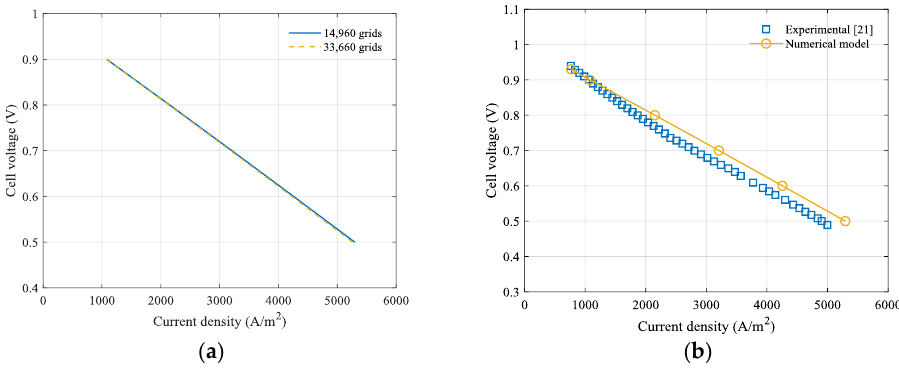
Figure 2. ( a ) Grid sensitivity test and ( b ) results comparison for validation with the results from the literature. The red circle and the blue square represent the numerical results of the present study and the experimental results of reference [29], respectively.